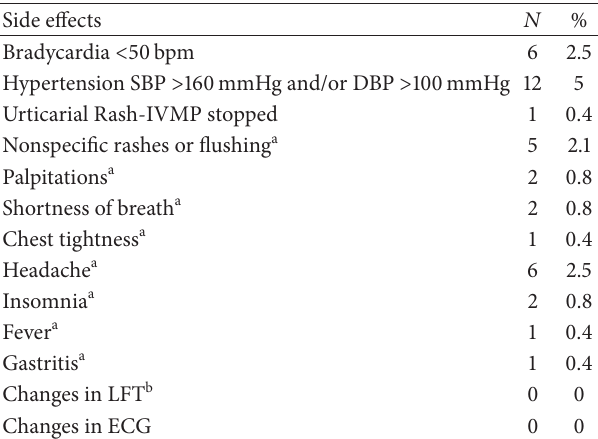
Table 3: Side effects (out of 242